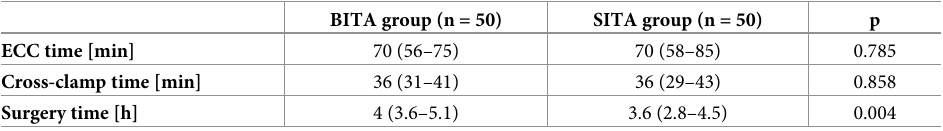
Table 2. Intraoperative data.